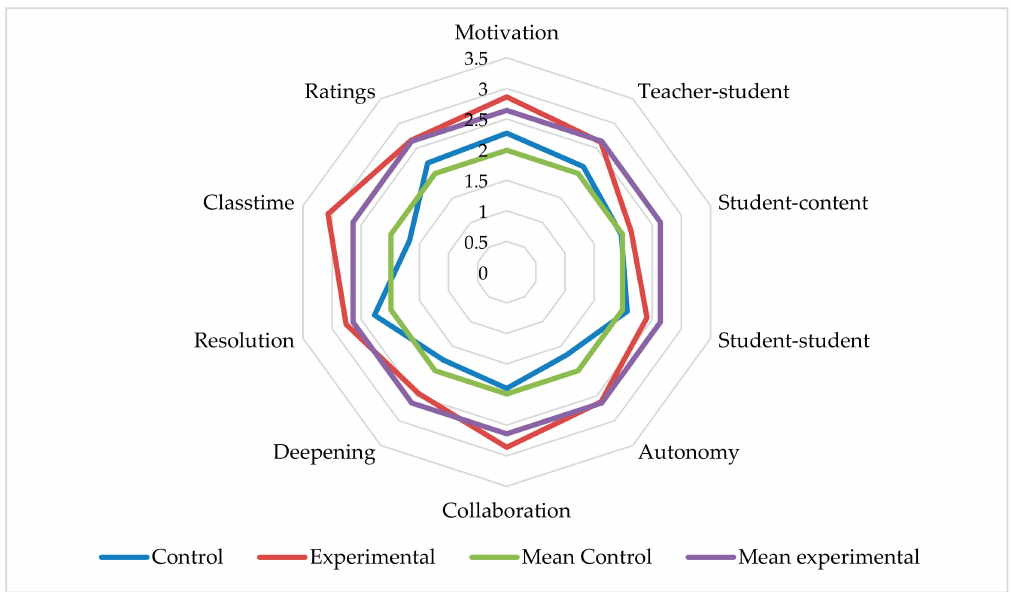
Figure 3. Comparison between control groups and experimental groups.